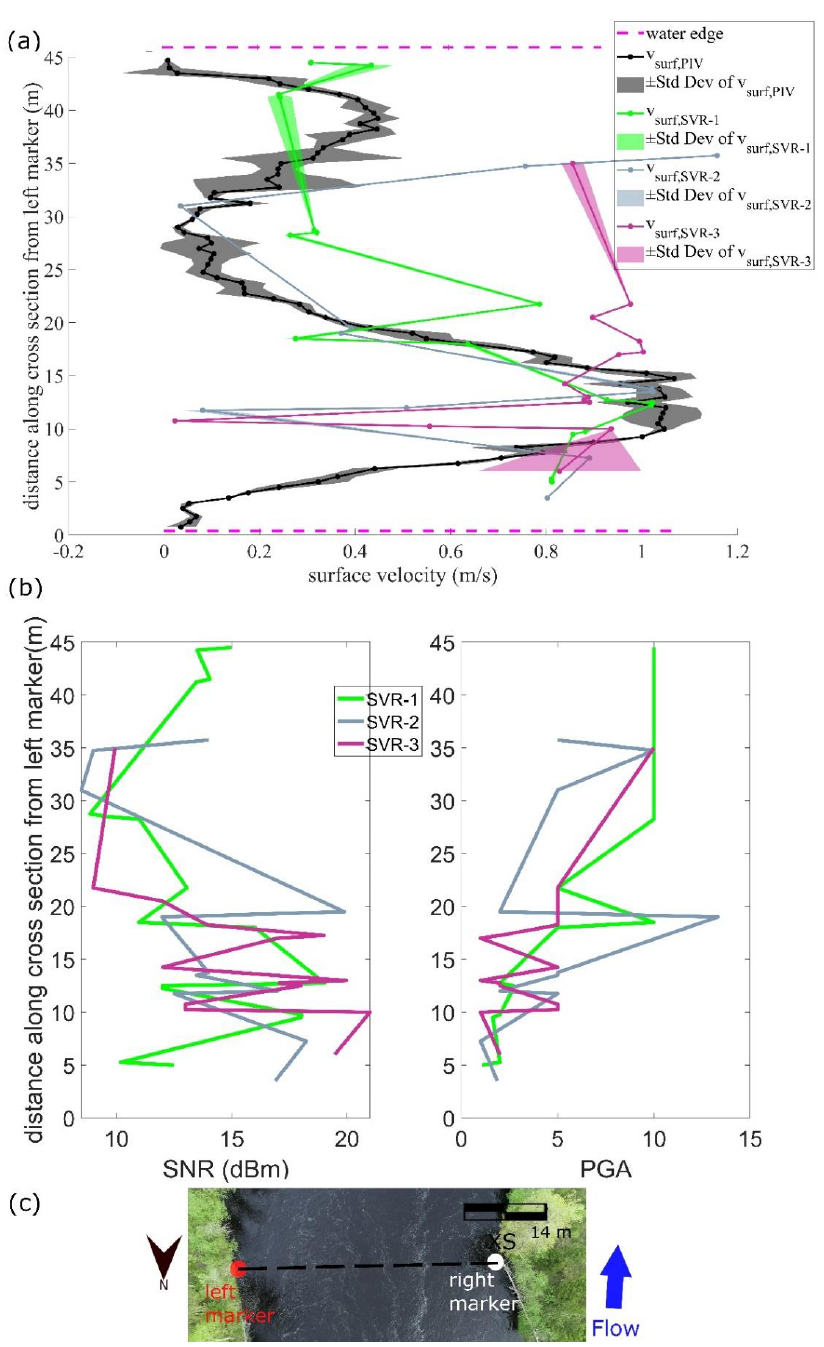
Figure 6. Ä tran XS (SE). ( a ) surface velocity comparing: UAS-borne PIV measurements (v surf,PIV ) and three UAS-borne SVR (v surf,SVR-1 , v surf,SVR-2 and v surf,SVR-3 , all of which pointing upstream) surveys. SVR and PIV are represented with shaded regions to present standard deviation (±Std Dev). ( b ) Com- parison of two quality indicators (SNR and PGA) for the SVR surveys. ( c ) UAS-borne video frame of the XS (North arrow, approximate flow direction and approximate scale are also shown).